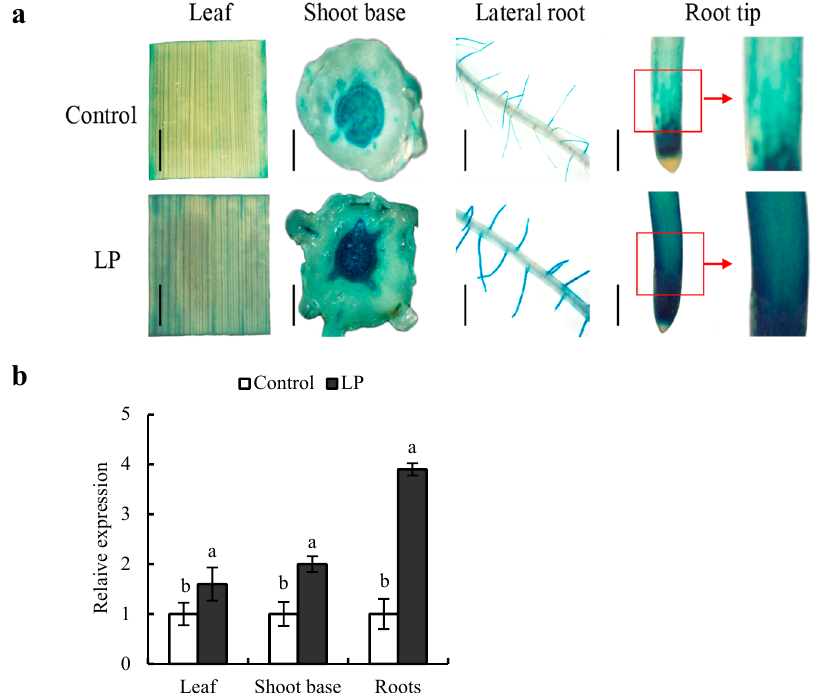
Figure 1. The expression of OsPIN2 in rice plants. Seedlings were grown in hydroponic media containing normal nutrition (control, 300 μ M P) or low P (LP, 10 μ M) for 6 h. Bar = 1mm. ( a ) pPIN2::GUS expression in leaf, shoot base, lateral root and root tip. ( b ), OsPIN2 expression in roots under control and LP conditions. OsPIN2 expression was normalized to that of OsACT . h = hours. Data are means ± SE of three replicates and bars with different letters indicate significant differences in same organ ( p < 0.05, ANOVA). All experiments included three independent biological replicates.